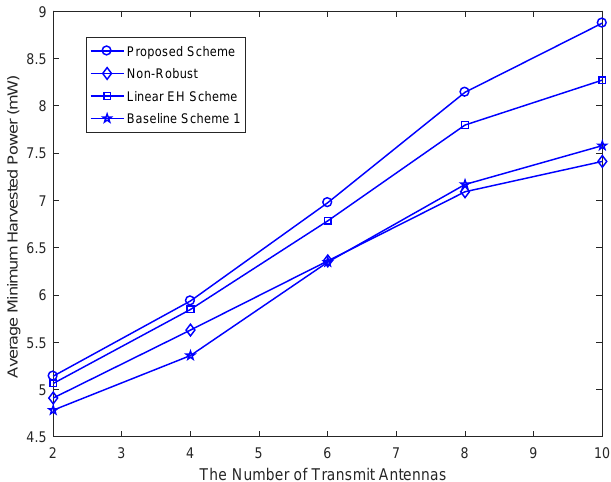
Figure 5. Average minimum harvested power per energy vehicular receiver versus the number of transmit antennae, N T .